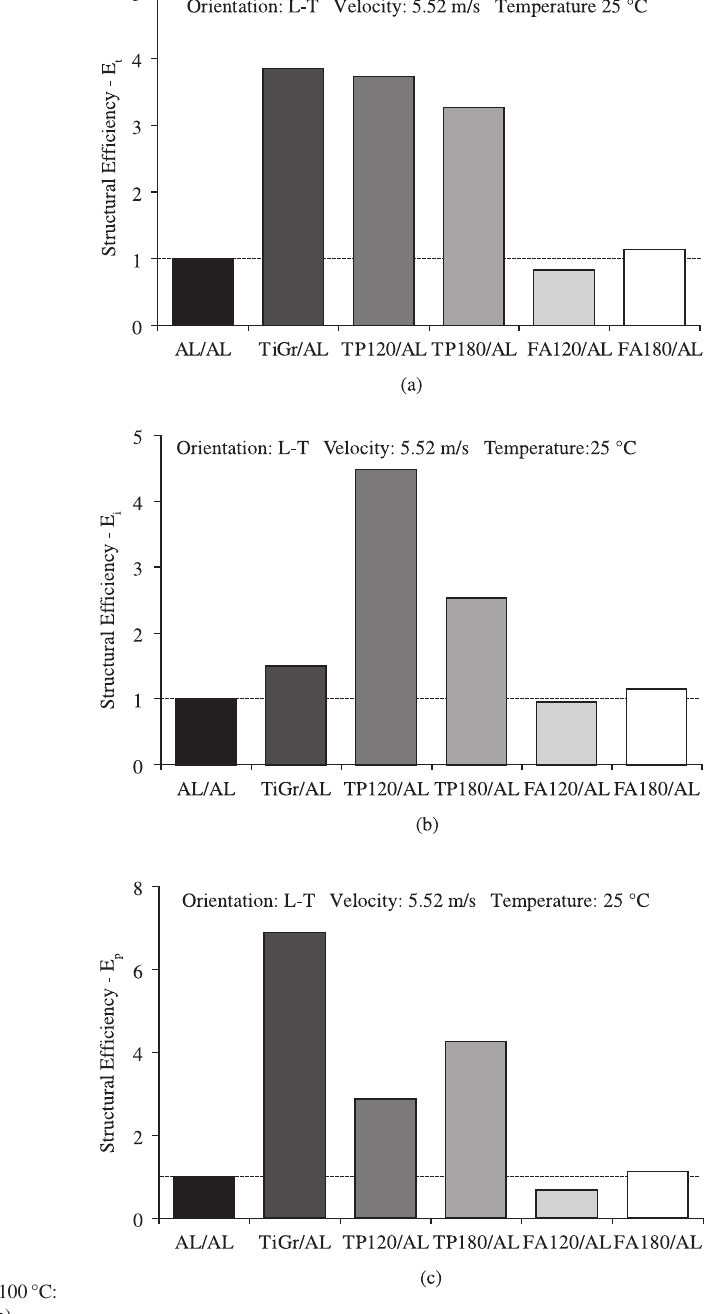
Figure 10. Structural efficiency charts normalized with respect to the impact performance of an Al-alloy (AL) at ambient temperature: a) Total fracture energy, E ,; b) Initiation fracture energy, E ; and c) Propagation fracture t i energy, E p